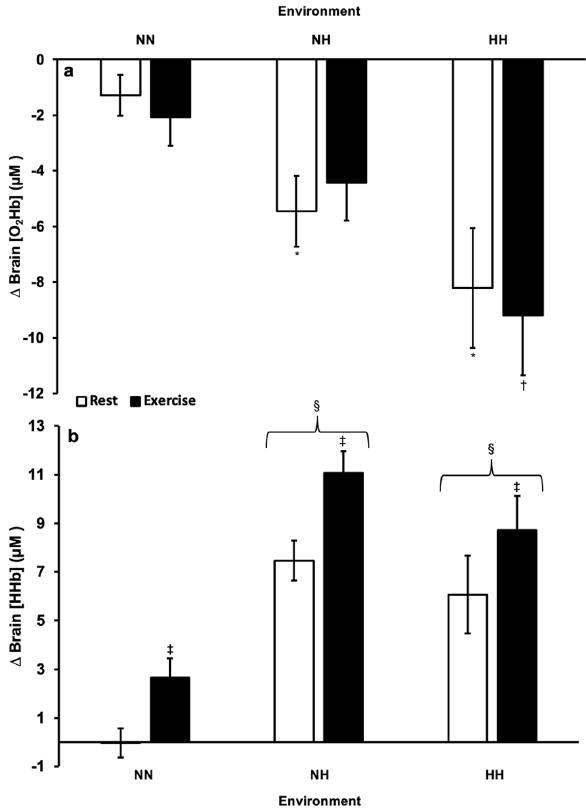
Figure 2. ( a ) Brain oxygenated (O 2 HB) and ( b ) deoxygenated (HHb) hemoglobin concentration change at normobaric normoxia (NN), normobaric hypoxia (NH), and hypobaric hypoxia (HH) during rest and exercise